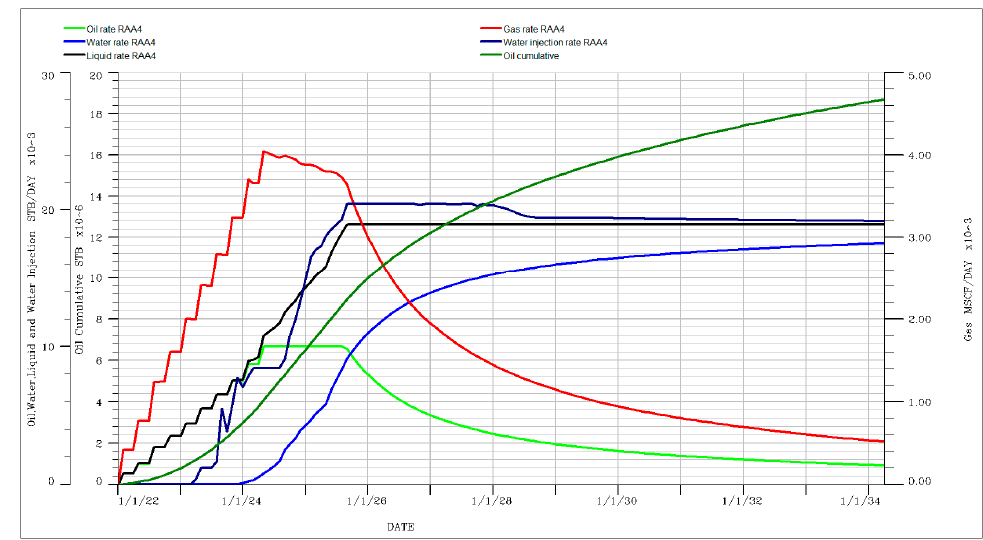
Figure 6. New Field Development.